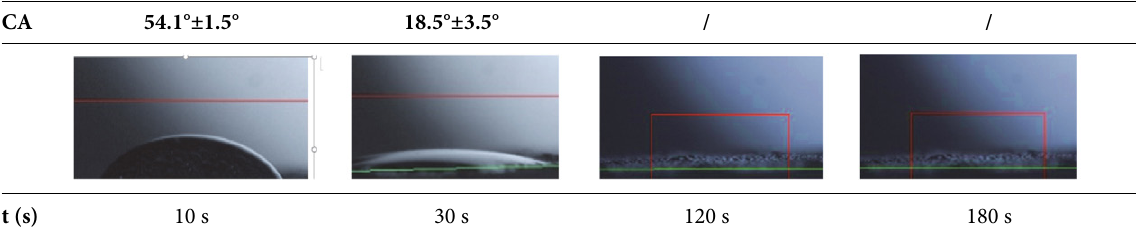
Table 4: Time-dependent contact angles of water droplets on naturally aged and damaged plasticized PVC membranes (location 2).